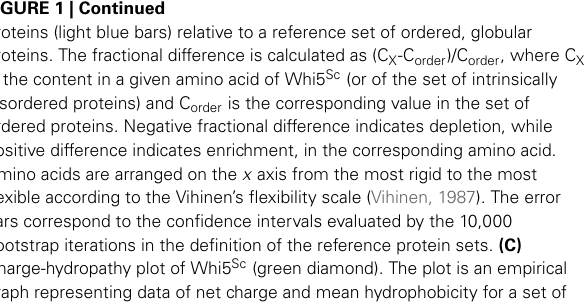
globular proteins (blue square) and a set of disordered proteins (red circle). The two groups are separated by a straight line < charge > = 2.743 < hydropathy > − 1.109 (Oldfield et al., 2005). (D) Cumulative plot of disorder prediction. (E) SDS-PAGE analysis of proteolysis kinetics on recombinant, IMAC-purified Whi5 Sc and SlyD, a copurified E. coli globular protein serving as a control. Trypsin and its substrates were mixed in a weight ratio of 1:2000 and the digestion products withdrawn to be assayed at different time points (1–60min). Recombinant Whi5 Sc was markedly degraded after 20-min incubation, while SlyD is resistant to proteolysis even after 60-min incubation (F) Analytical size-exclusion chromatogram of recombinant Whi5 Sc